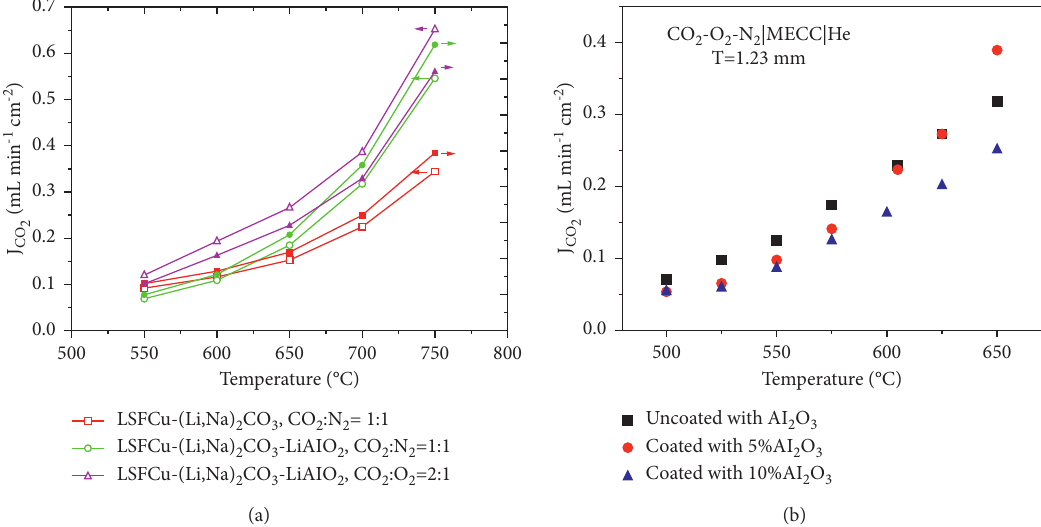
Figure 14: (a) CO 2 fluxes for LSFCu-(Li, Na) 2 CO 3 and LSFCu-(Li, Na) 2 CO 3 samples modified with LiAlO 2 as a function of temperature [65]. (b) CO 2 fluxes for Ag-MC membranes coated with Al 2 O 3 as a function of temperature